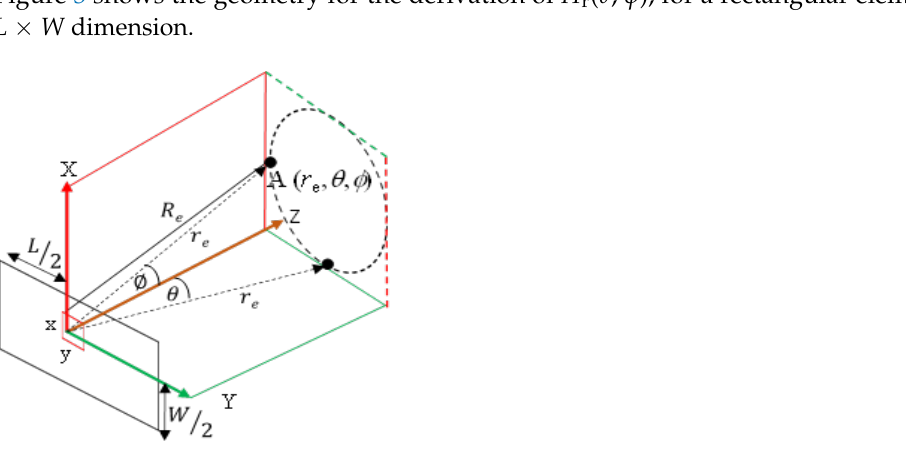
Figure 3. Analytical geometry for calculating the directional factor of the rectangular element.